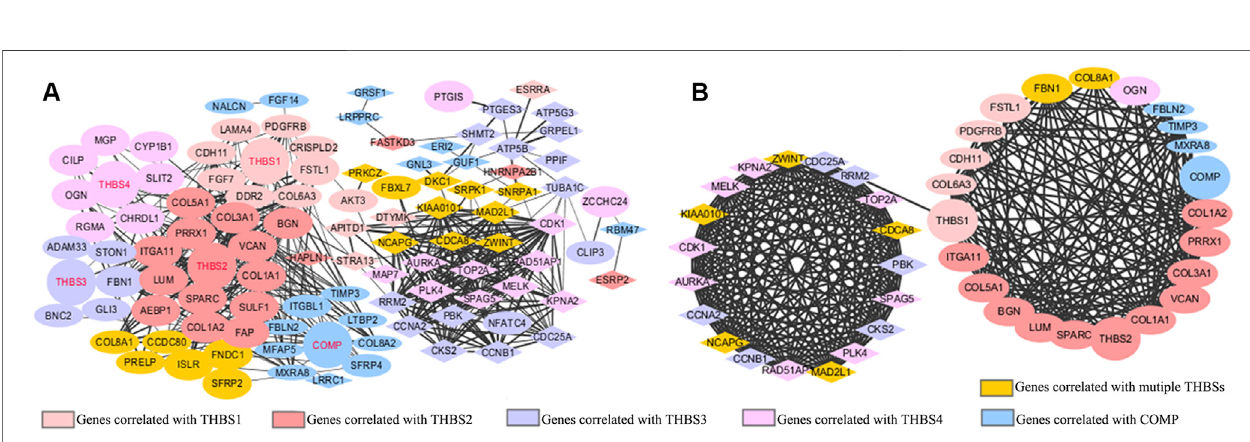
FIGURE 5 | Protein – protein interaction (PPI) network of (A) the top 20 positively and top 20 negatively correlated genes of each THBSs ; (B) potential hub genes (node degree ≥ 10). Ellipses stand for positively correlated genes, triangles stand for negatively correlated genes, a larger size of the node stands for a larger absolute value of Spearman correlation coef fi cient, and a wider line stands for a larger combined score (LinkedOmics and Cytoscape).